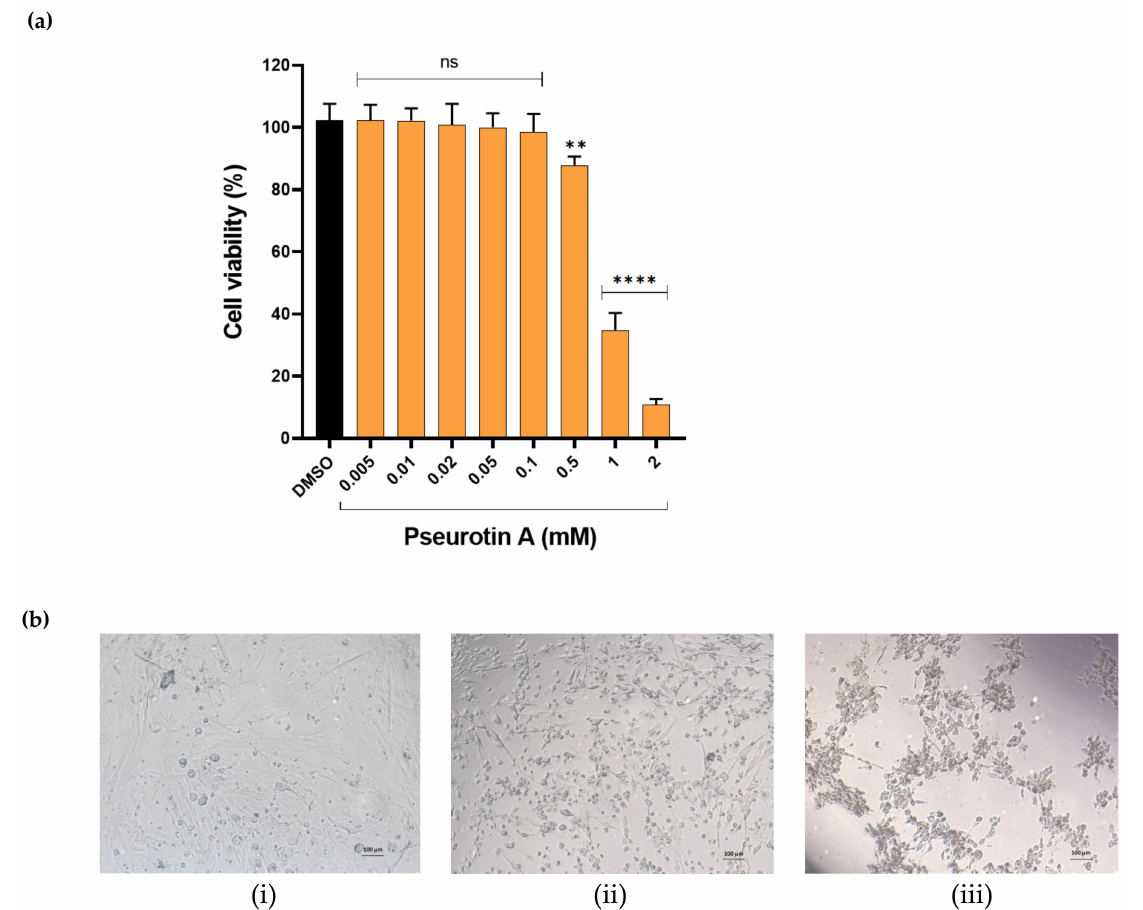
Figure 2. The effect of PsA treatment on the viability of the human CCD 841 CoN non-tumorigenic colon cells determined by the standard MTT protocol. ( a ) Bar graph shows the dose response of cytotoxic effect of PsA over 24 h treatment period. ( b ) Representative images (scale bar embedded) of human CCD 841 CoN non-tumorigenic colon cells over 24 h treatment period. ( i ) Vehicle-treated control cells. ( ii ) Cells treated with PsA at 1 mM concentration. ( iii ) Cells treated with PsA at 2 mM concentration. Data shown as mean ± SD of triplicate wells. ** indicates a statistical significance at p < 0.01, while **** indicates a statistical significance at p < 0.0001, at specified concentrations vs. DMSO-treated control cells. ns indicates non-statistical significance at p < 0.05.